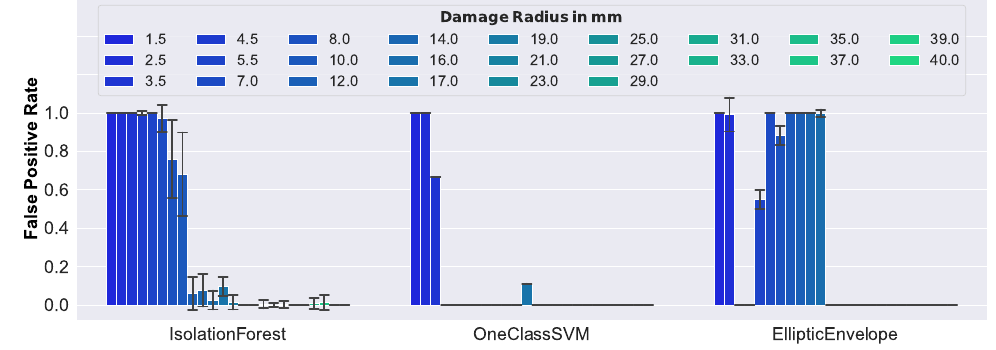
Figure 16. False positive rates of real-world